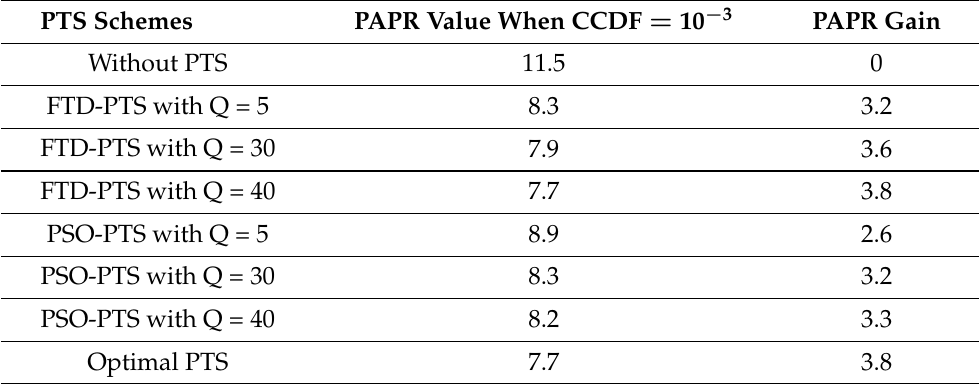
Figure 12. The performance comparison of FTD-PTS and PSO-PTS. Table 7. PAPR reduction performance comparison of FTD-PTS and